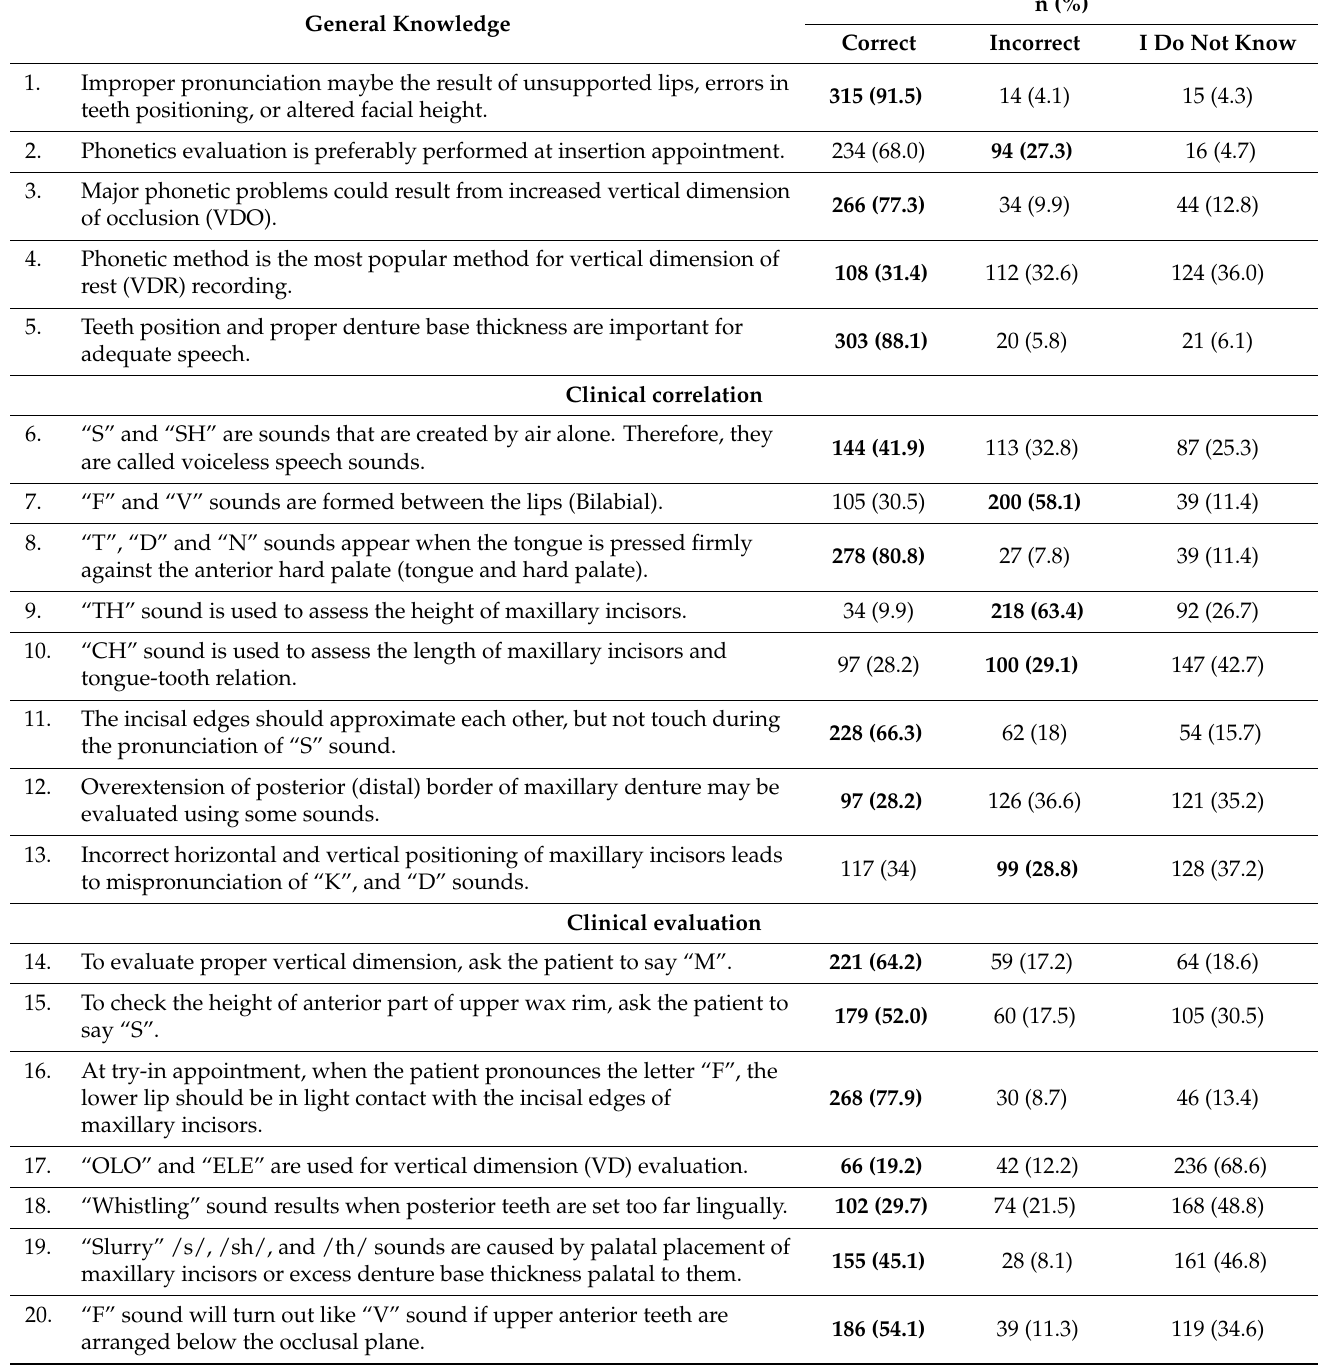
Table 1. Proportion of correct/incorrect/I do not know responses for each question. Bold font indicates the correct